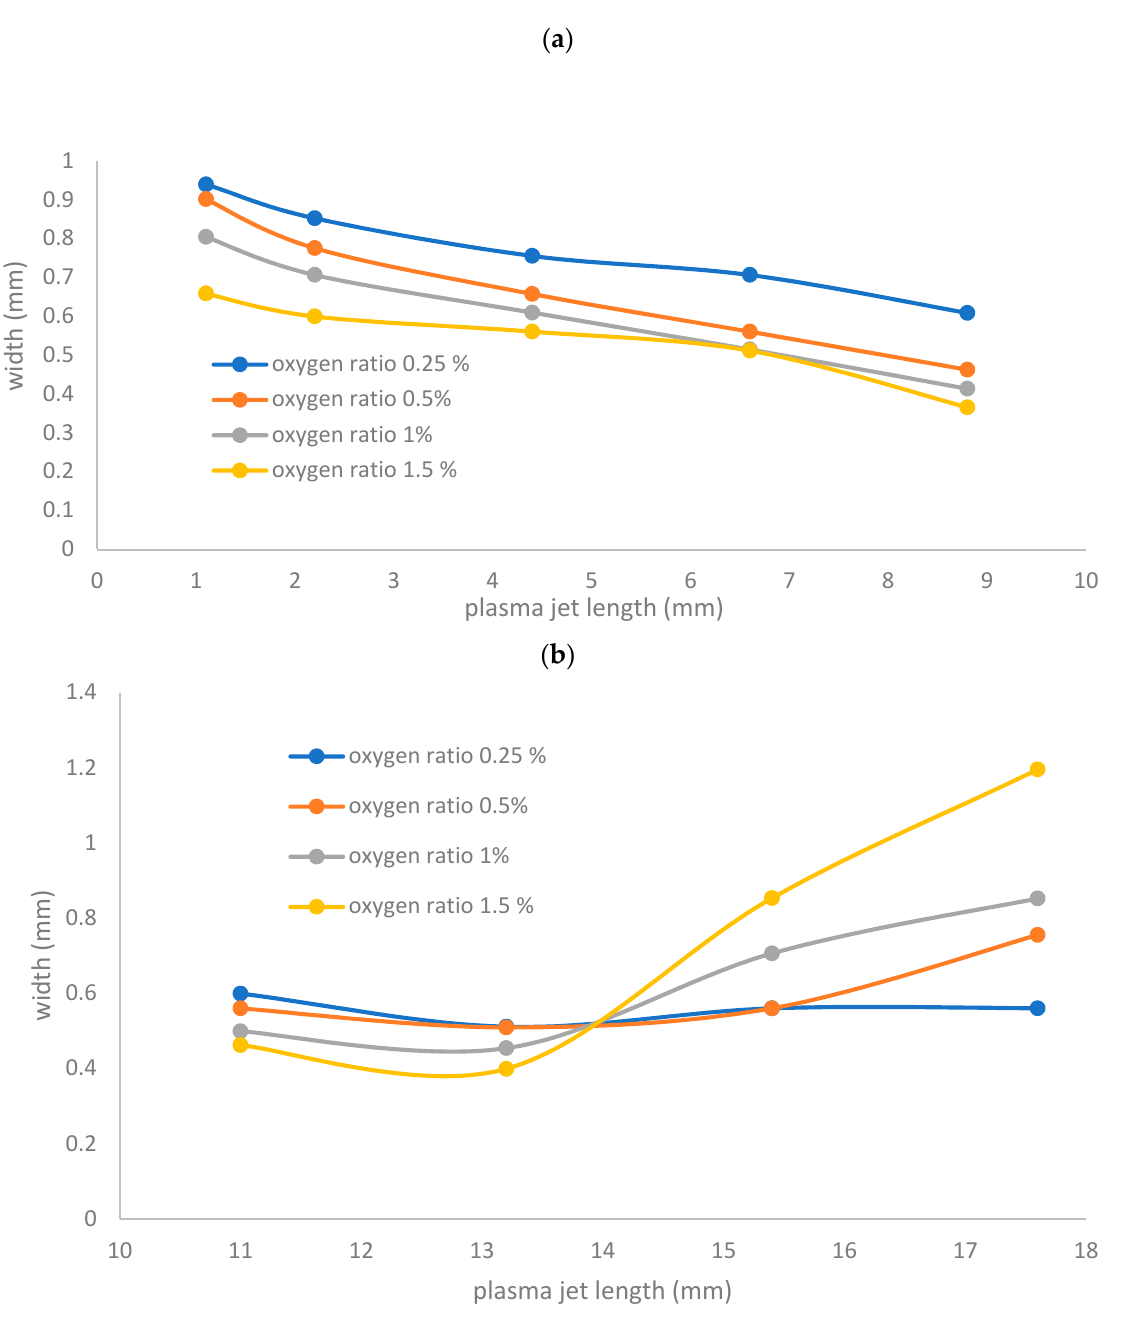
Figure 7. ( a ) Jet width for wet argon as a function of plasma jet length less than 10 mm and at different applied flow rate ratios of oxygen. ( b ) Jet width for wet argon as a function of plasma jet length ranging from 11 to 18 mm and at different applied flow rate ratios of oxygen. Table 3. Largest width of the jet for dry argon discharge and the equivalent length.